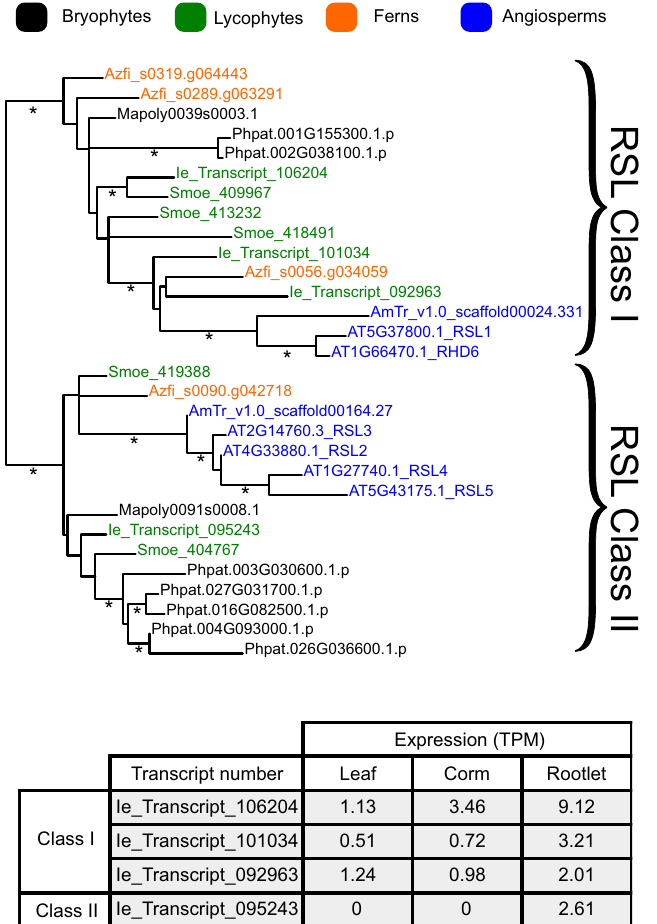
Figure 4. Gene tree analysis and expression analysis of I. echinospora RSL genes. Top, maximum likelihood gene tree of RSL genes generated in PhyML 3.0 47 . Gene names: black, bryophytes; green, lycopsids; orange, ferns; blue, angiosperms. The RSL genes are grouped into two monophyletic classes; Class I and Class II. Bottom, gene expression in the three RSL Class I genes and single RSL Class II gene in the I. echinospora transcriptome. Expression in transcripts per million (TPM) given for the single replicate of rootlets and as an average of the two technical replicates of leaf and corm. Species name abbreviations: Phpat, Physcomitrella patens ; Mapoly, Marchantia polymorpha ; Some, Selaginella moellendorffii ; Sk, Selaginella kraussiana ; Ie_Transcript, Isoetes echinospora ; Sacu, Salvinia cucullata ; Azfi, Azolla filiculoides ; AmTr, Amborella trichopoda ; AT Arabidopsis thaliana . *Indicate branches with over 0.85 aLRT SH-like